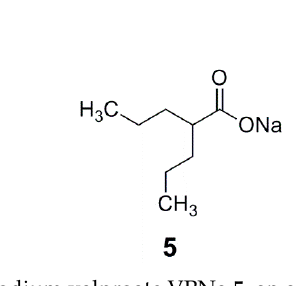
Figure 3. Sodium valproate VPNa 5 , an antiepileptic